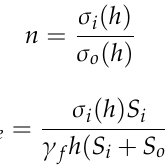
Figure 5. Interaction between the conical head and the soil. By associating Equation (12) with Equation (13), the following equation can be obtained: **